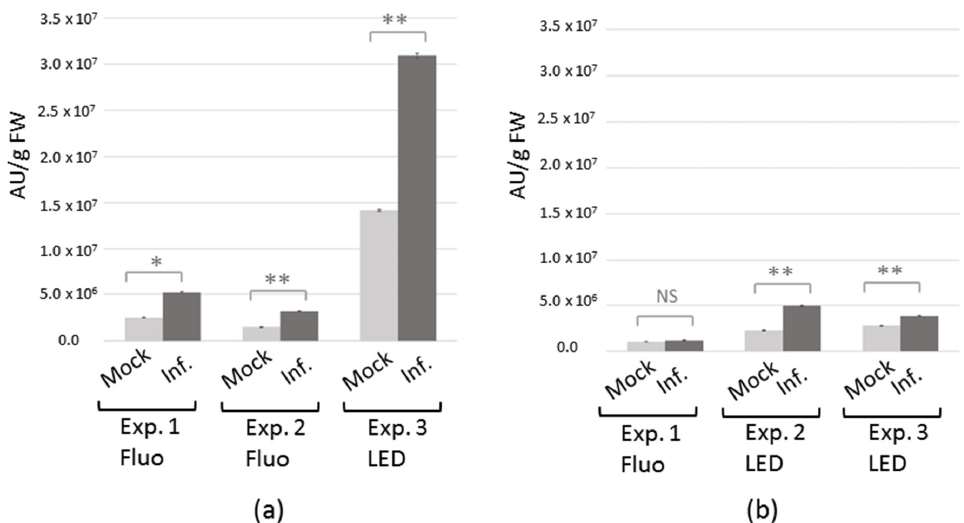
Figure 1. Impact of Turnip yellows virus (TuYV) infection on the relative emission of volatiles collected from entire C. sativa ( a ) and A. thaliana ( b ) plants. Bars (black for TuYV-infected plants and grey for mock-inoculated plants) represent the mean total chromatogram area ± SE (3 experiments with n = 5 replicates of two plants for C. sativa ; three experiments with n = 5 replicates of seven plants for A. thaliana ), expressed in area units (AU) per g of fresh weight (FW). The light source used to grow plants is indicated (Fluo = cool-white fluorescent lights and LED = Light-emitted diode lamps). Statistical significance of differences was tested using the Wilcoxon test. NS = not significant = p -value > 0.05; * = 0.01 < p -value ≤ 0.05; ** = p -value ≤